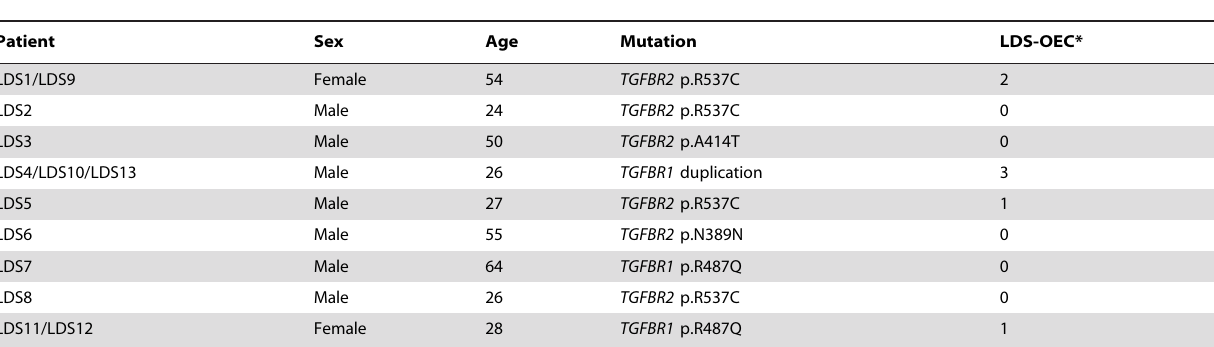
Table 2. LDS patients analysed for OEC